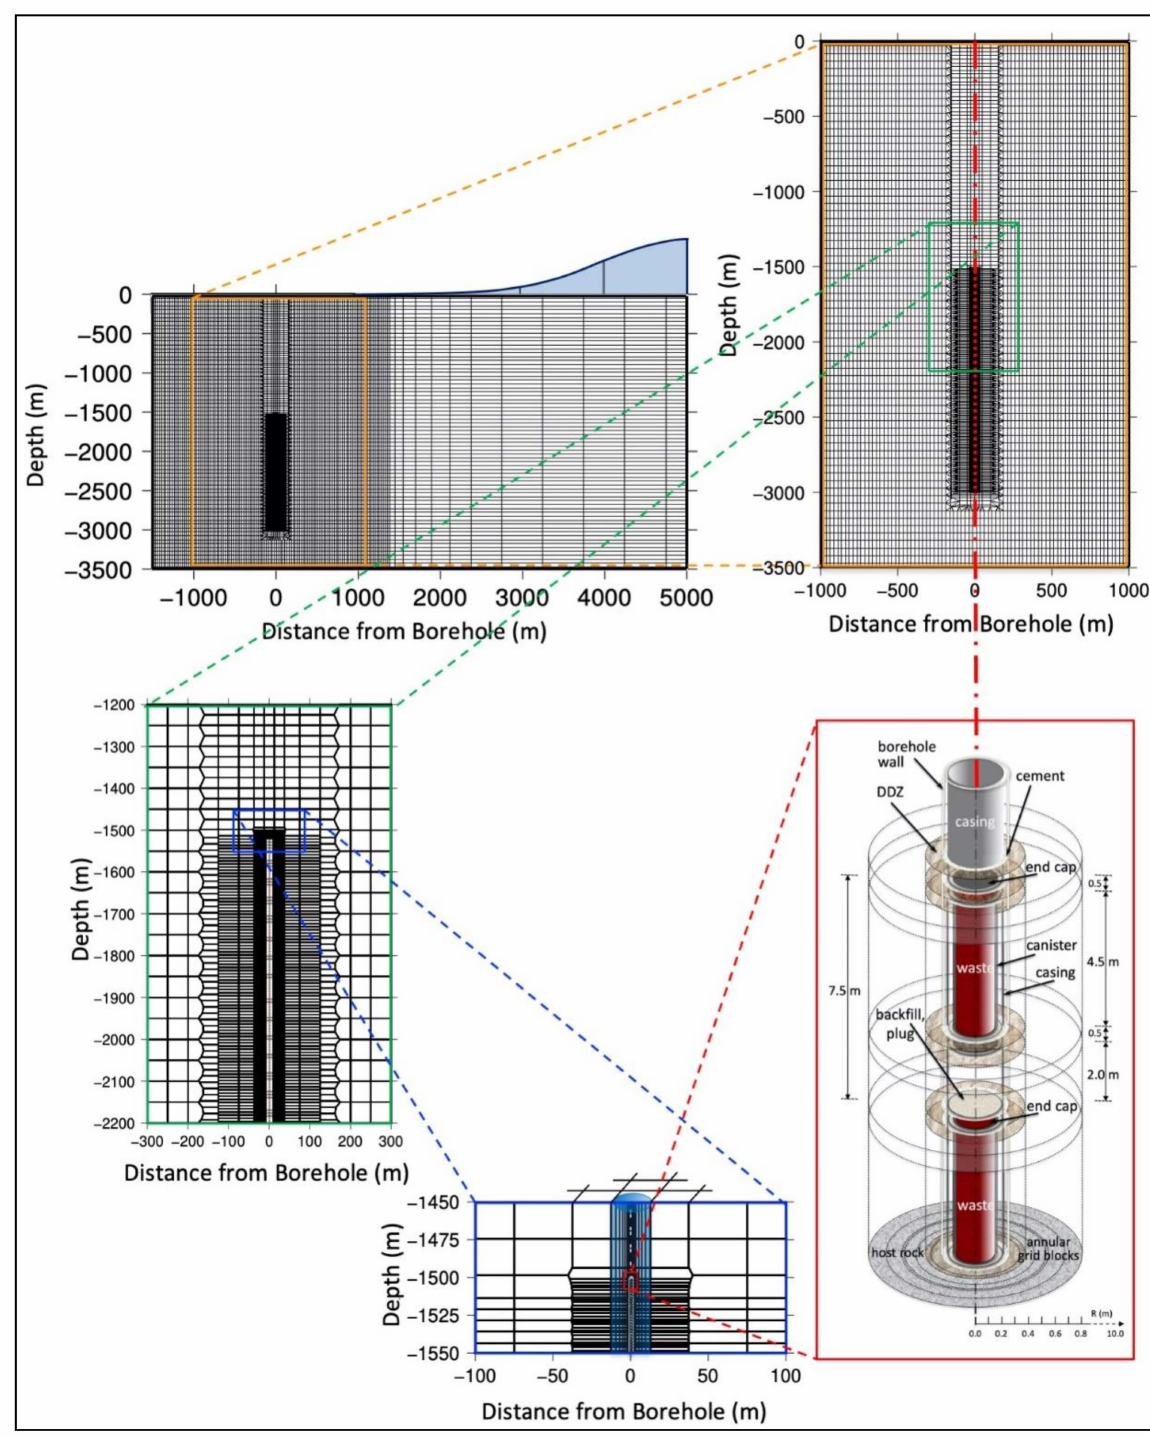
Figure 2. Cross sections through unstructured computational grid, showing nested mesh refinement; a two-dimensional, radial-axial subgrid representing the borehole, engineered barrier system, and near field is integrated into the three- dimensional Cartesian mesh of the far